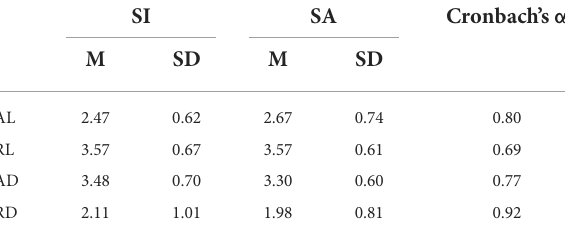
TABLE 4 Characterization of suicidal attitude using the MAST scale in the two